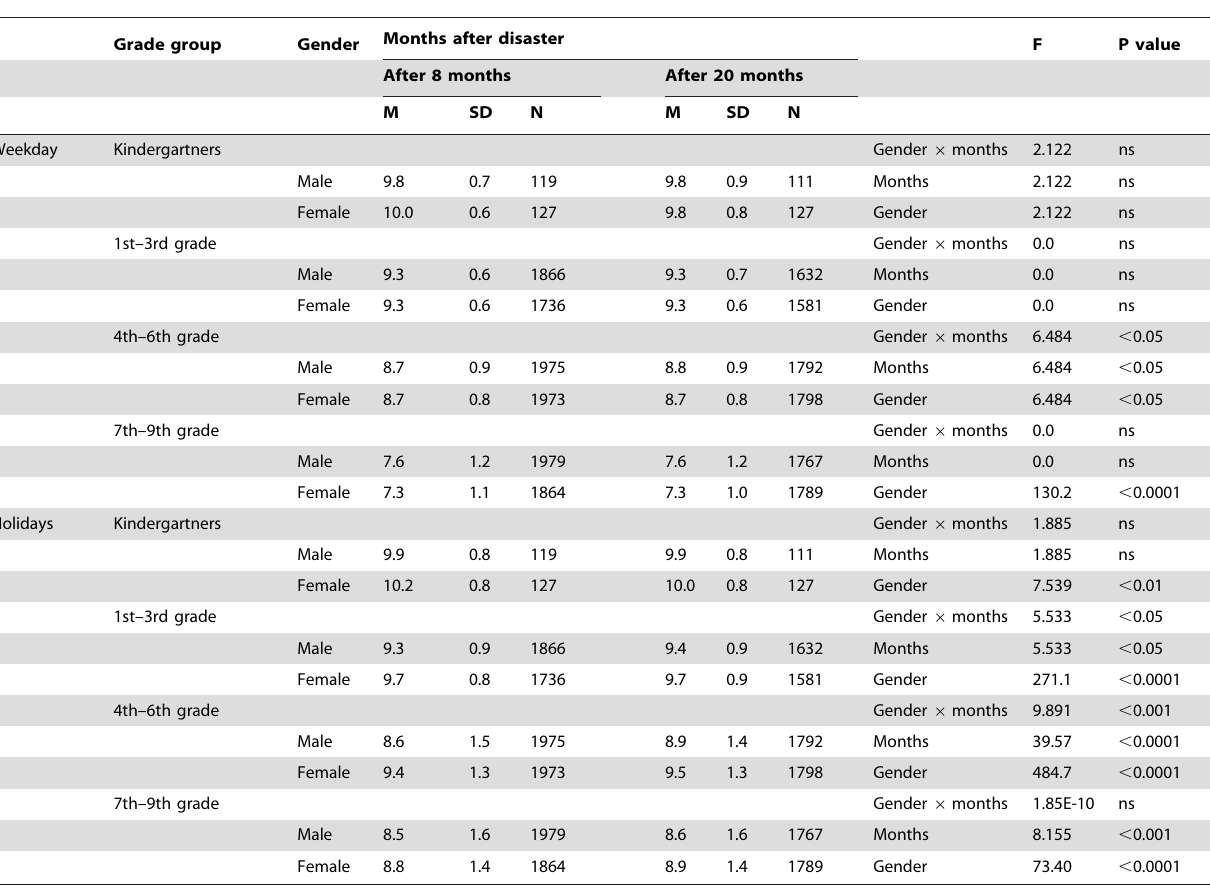
Table5. Average sleep duration on weekdays and holidays (grade, gender, and month).